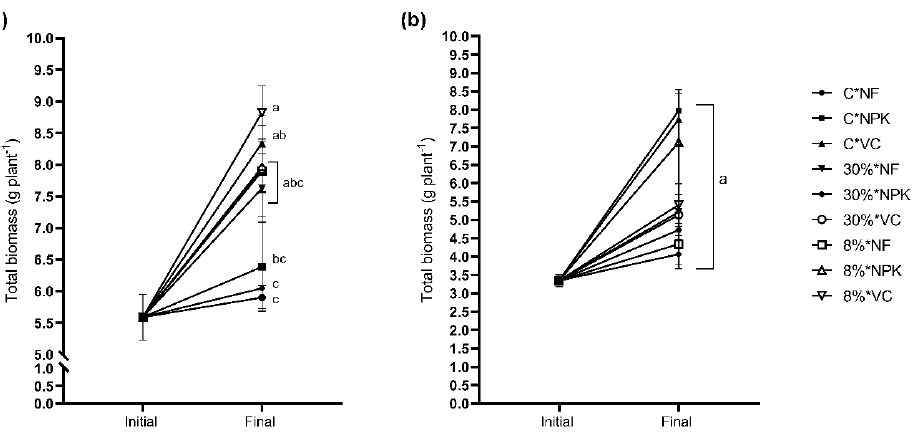
Figure 8. Total biomass of Shorea leprosula Miq . ( a ) and Shorea acuminata Dyer ( b ) in response to the interaction factor, light × nutrient. Alphabets denote significant differences between light × nutrient interaction.